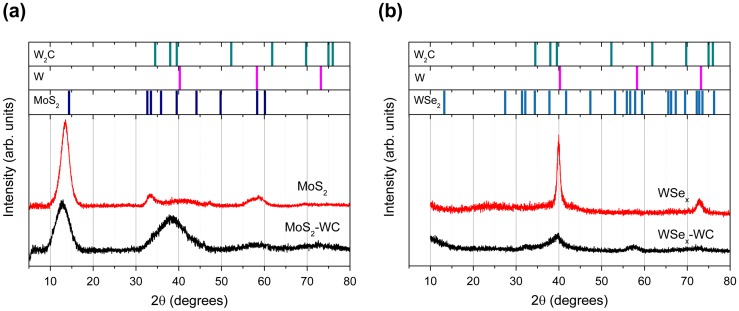
XRD diffractograms of the MoS2 (a) and WSe2-based (b) coatings.